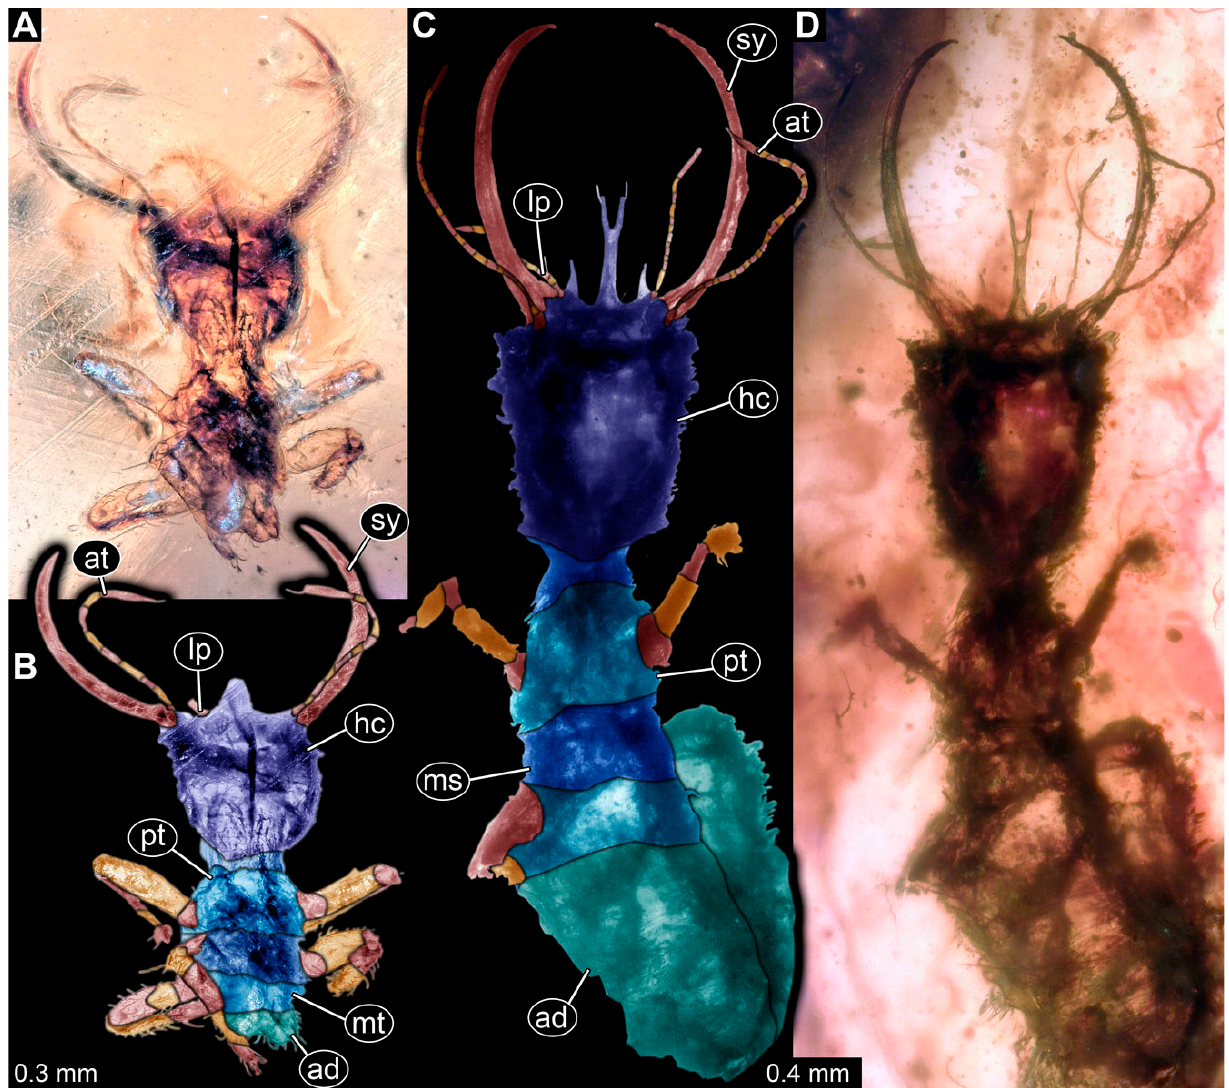
Figure 8. Specimens in Myanmar amber. ( A , B ) Specimen 61 (PED 0440). ( A ) Dorsal view. ( B ) Dorsal view, colour-marked. ( C , D ) Specimen 84 (PED 1884). ( C ) Dorsal view, colour-marked. ( D ) Dorsal ( D ) Dorsal view. Abbreviations: ad = abdomen; at = antenna; hc = head capsule; lp = labial